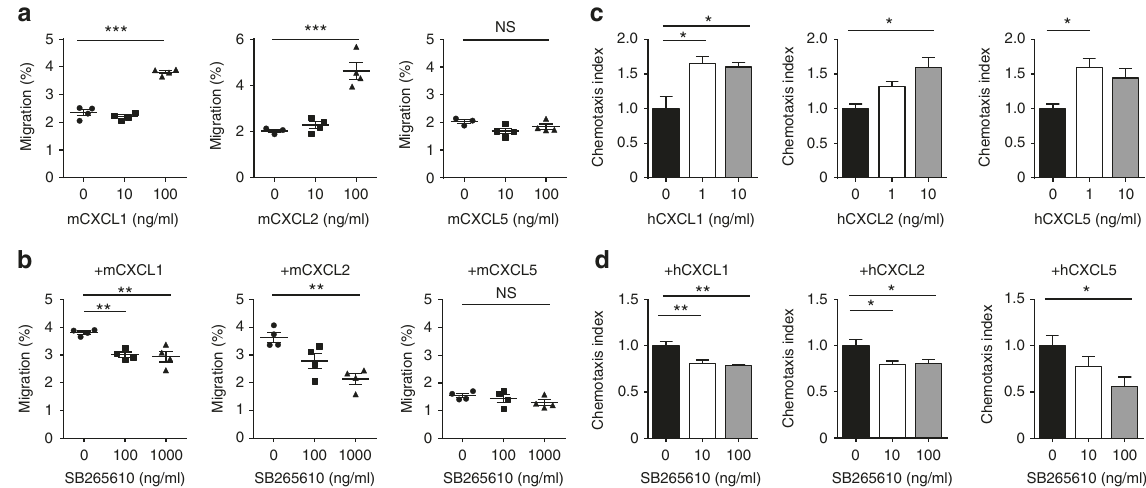
Fig. 6 CXCR2 ligands induce myeloid-derived suppressor cell in fi ltration. a Chemotaxis of mouse MDSCs, from subcutaneous tumor of HM-1 tumor- bearing mice, in response to CXCL1, CXCL2, and CXCL5; n = 4. b Chemotaxis of mouse MDSCs, from subcutaneous tumor of HM-1 tumor-bearing mice, pre-treated with SB265610 (CXCR2 antagonist) at each concentration in the presence of each CXCR2 ligands (at 100 ng/mL); n = 4. c Chemotaxis response of MDSCs, from human ovarian cancer ascites, to CXCL1, CXCL2, and CXCL5. The chemotaxis index is shown; n = 4. d Chemotaxis response of human MDSCs treated with SB265610 at each concentration in the presence of each CXCR2 ligands; n = 4. * P < 0.05, ** P < 0.01, and *** P < 0.001 (one- way ANOVA with Tukey ’ s multiple comparisons test in a – d